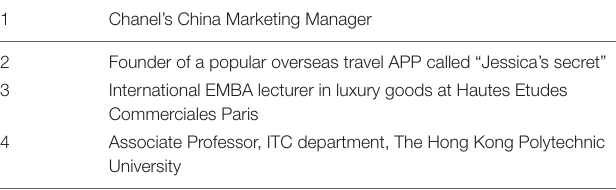
TABLE 1 | Identity of interviewee expert a